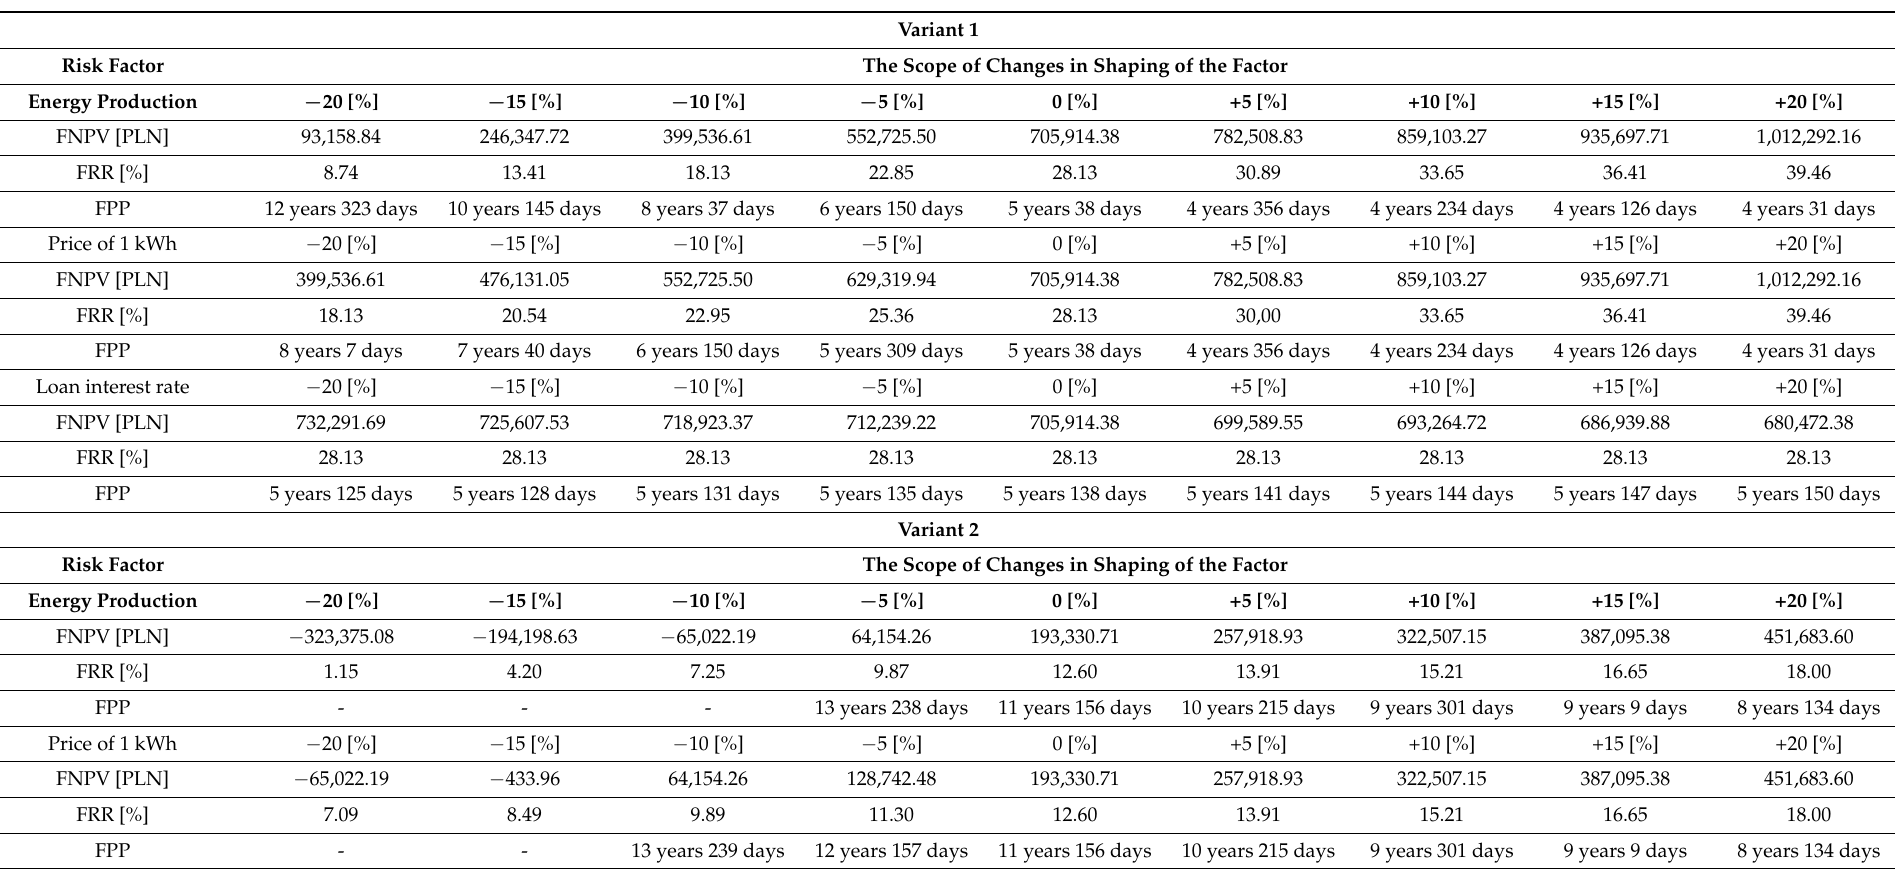
Table 23. Assessment of the financial effects, taking into account changes in the shaping of risk factors for additional project financing variants. Source: designed by